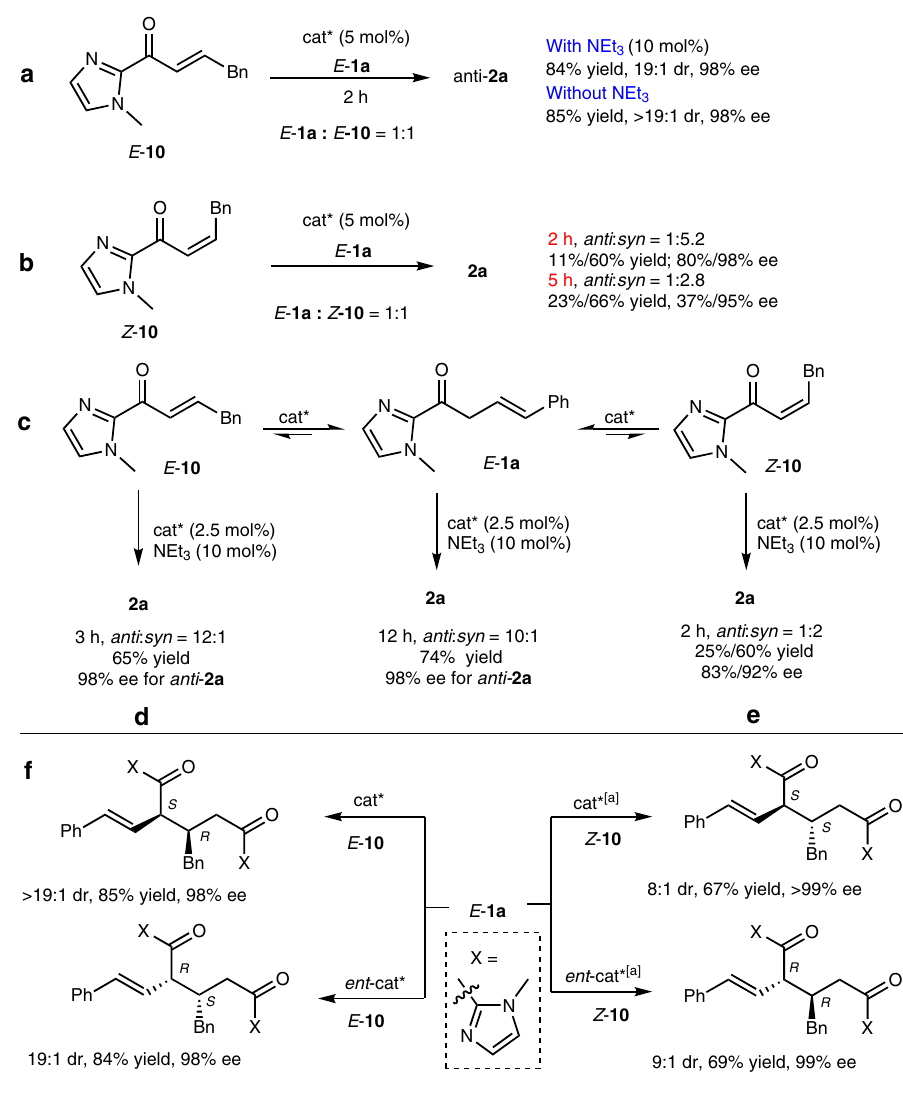
Fig. 7 Mechanistic studies. a Reaction of E -10 with E -1a . b Reaction of Z -10 with E -1a . c Isomerization of E -1a with E -10 and Z -10 . d Reaction of single E - 10 . e Reaction of single Z - 10 . f Stereodivergent synthesis of 2a . [a] m -Xylene was used instead of